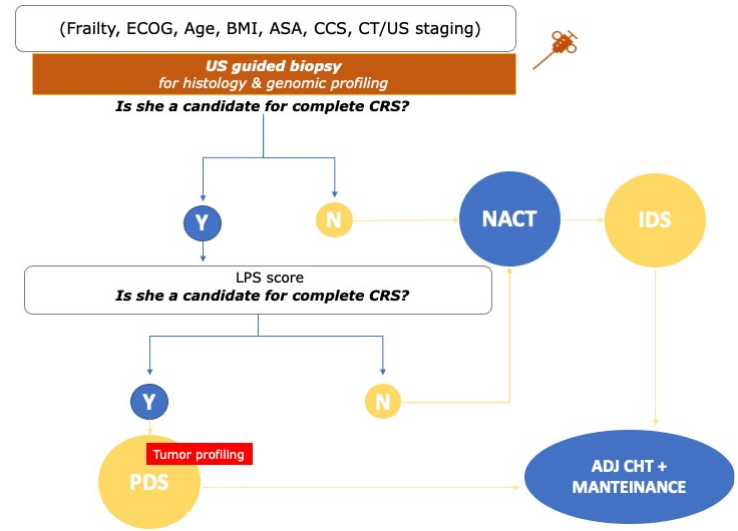
Figure 1. Future perspectives on selection of advanced ovarian cancer patients for primary surgery.